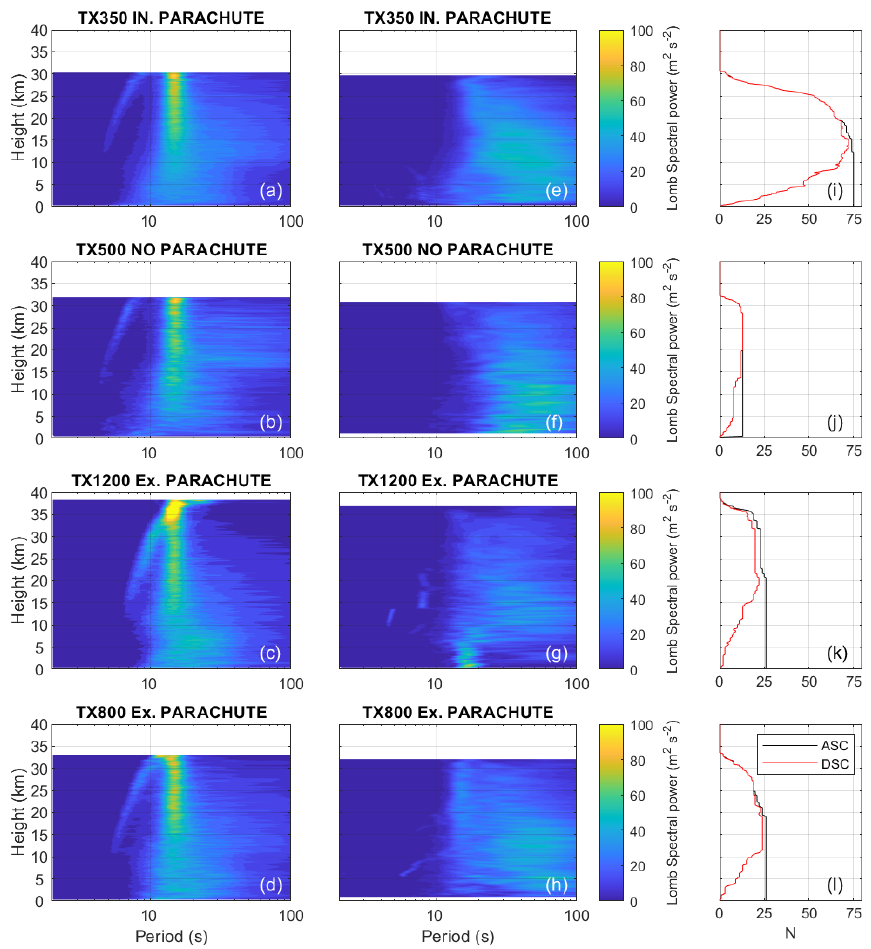
Figure 7. Composite Lomb periodograms of detrended horizontal GPS data as a function of height for ascent data from RS41s with the fol- lowing launch configurations: (a) TX350 balloon with internal parachute, (b) TX500 with no parachute, (c) TX1200 with external parachute (daytime only) and (d) TX800 with external parachute. Panels (e) – (h) show composite Lomb periodograms of descent data from the bal- loon configurations shown in panels (a) – (d) respectively. Profile contributions for the balloon configurations in panels (a) – (d) during ascent (descent) are shown in black (red) in panels (i) – (l)